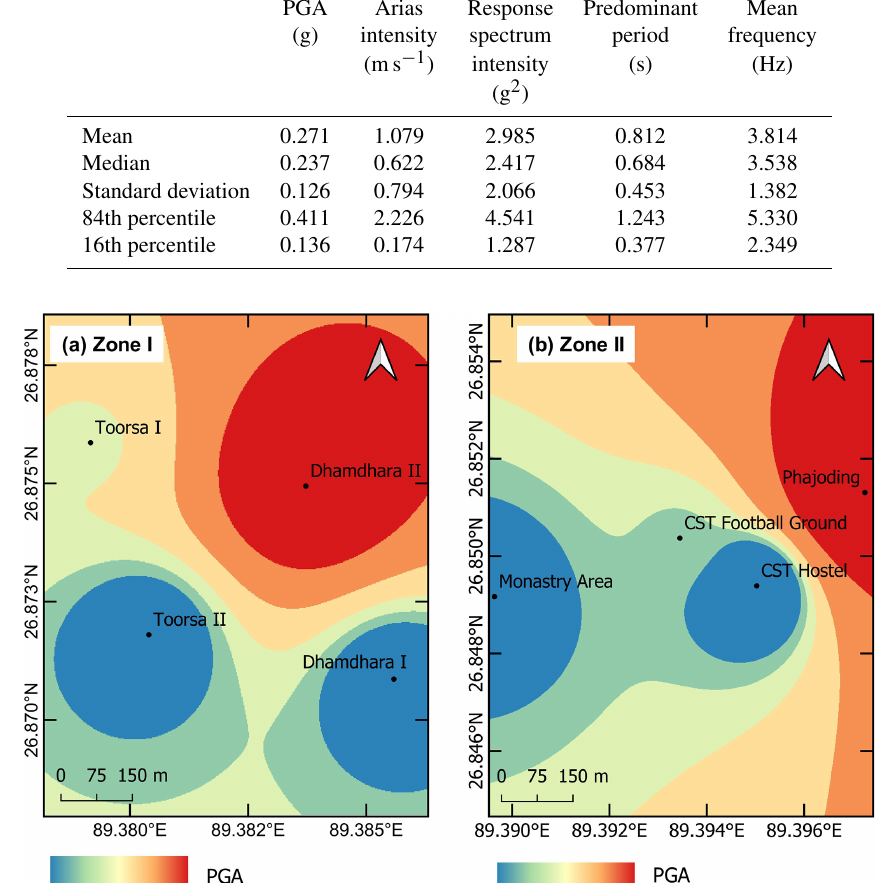
Table 5. Descriptive statistics for averaged ground motion parameters in Zone II for all four soil profiles and six input ground motions.